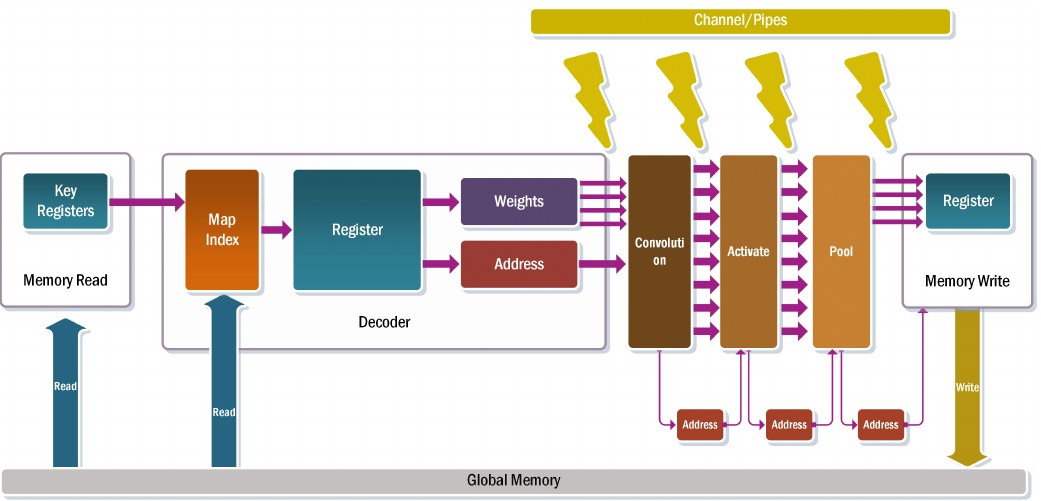
Figure 2. CNN computational process overview.